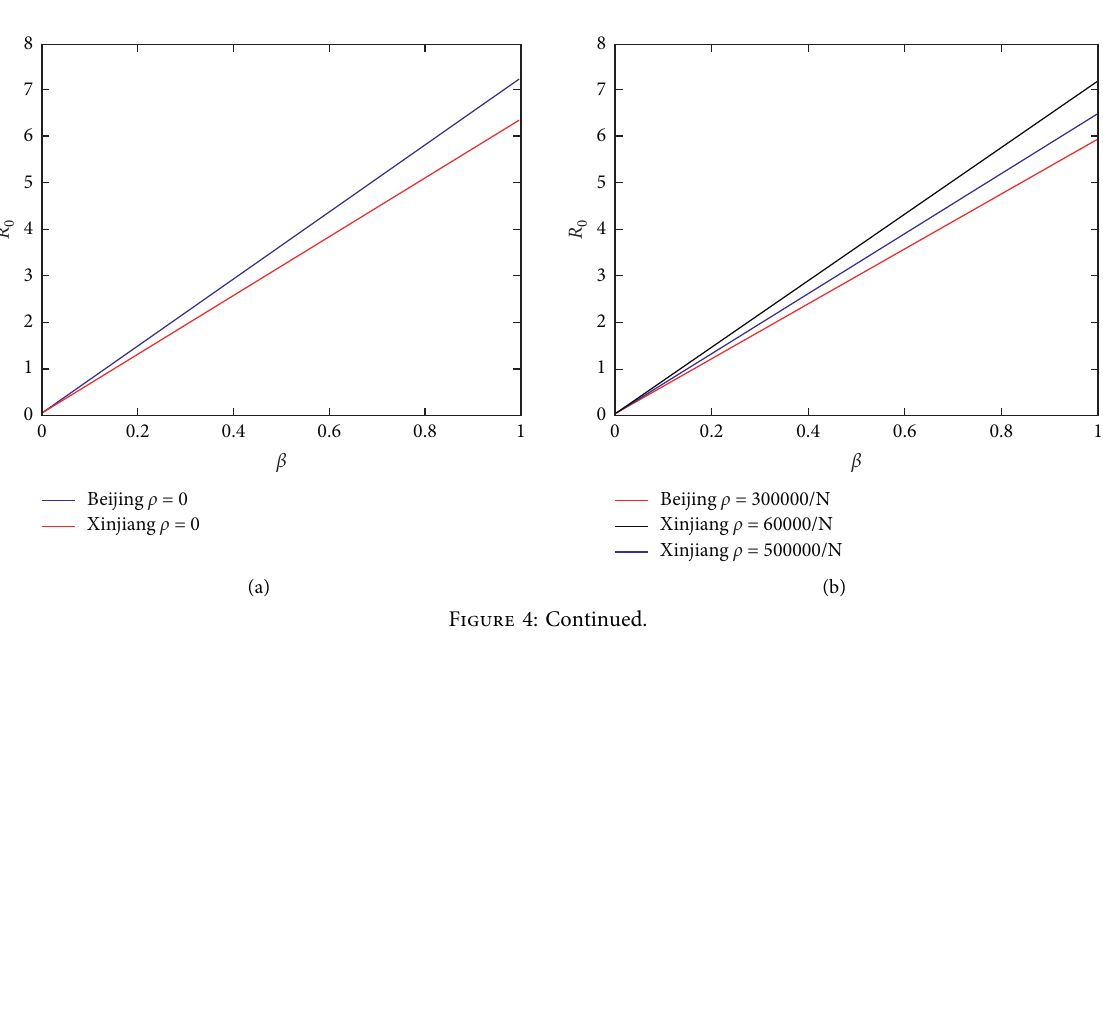
Figure 3: Cumulative number of confirmed and identified asymptomatic COVID-19 cases on κ in (a) Beijing and (b) Xinjiang.